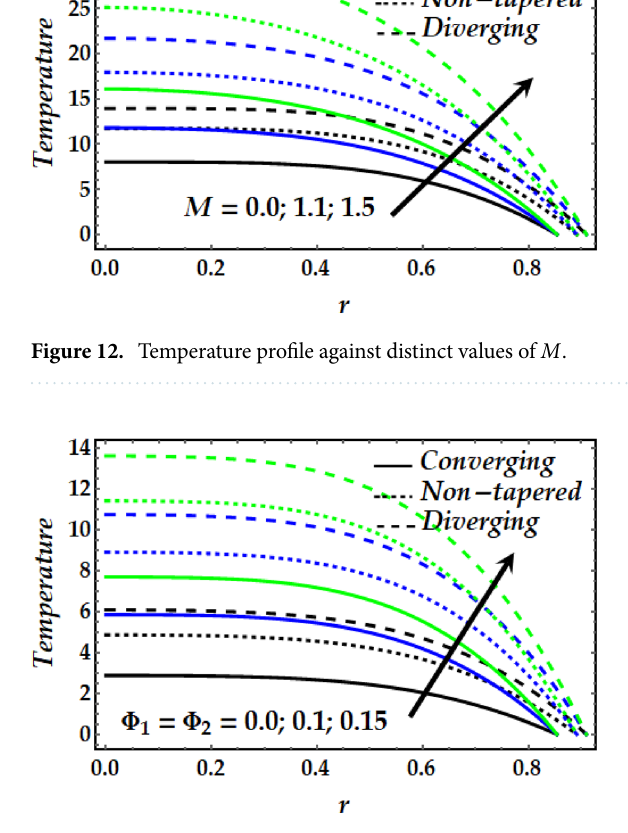
Figure 13. Temperature profile against distinct values of (cid:31) 1 , (cid:31) 2 .